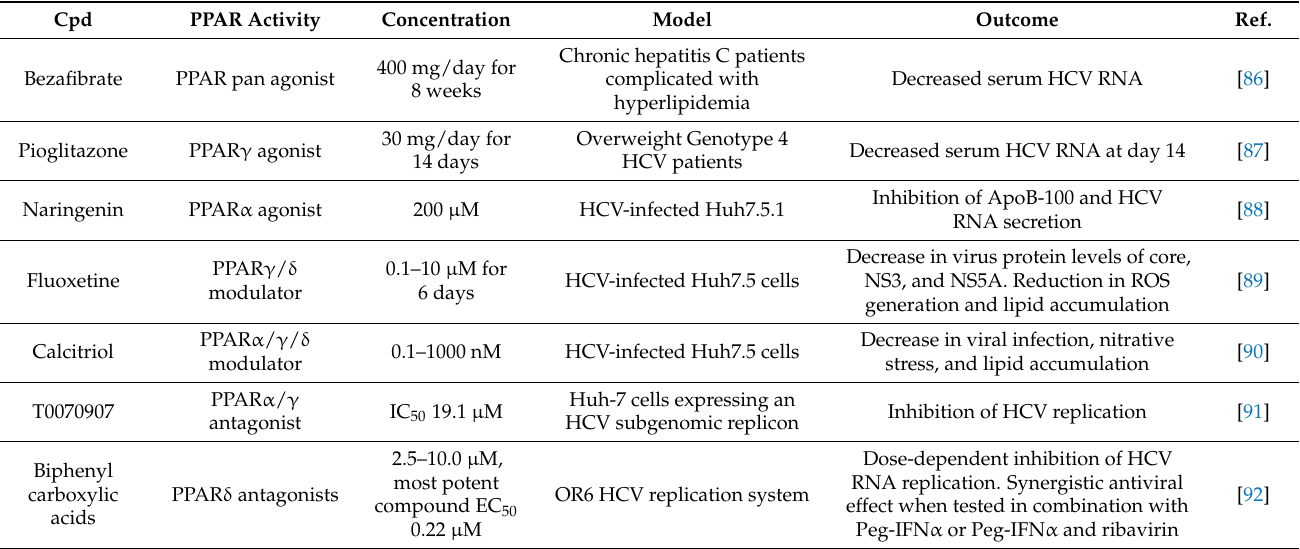
Table 2. Summary of PPAR ligands in vivo or in vitro tested in HCV infection.